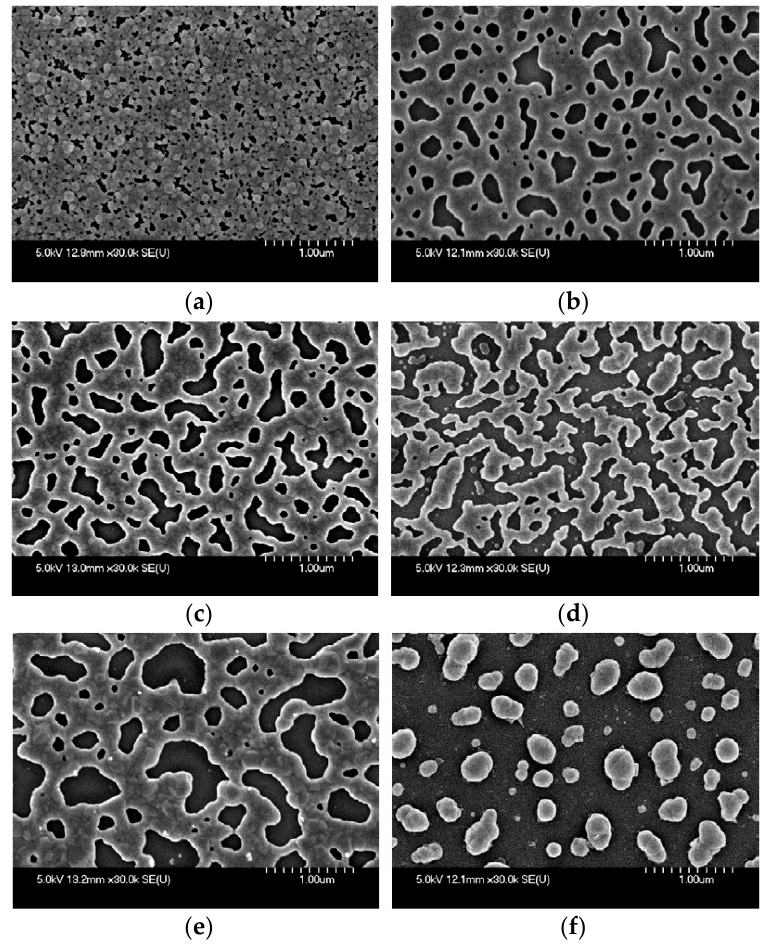
Figure 1. Scanning electron microscopy (SEM) images of Ag nanoparticles (NPs) at different temperatures and of changes in pores’ morphology by increasing the sintering temperature: ( a ) 100 °C, ( b ) 200 °C, ( c ) 250 °C, ( d ) 300 °C, ( e ) 350 °C, and ( f ) 400 °C. Reproduced with permission from [10].